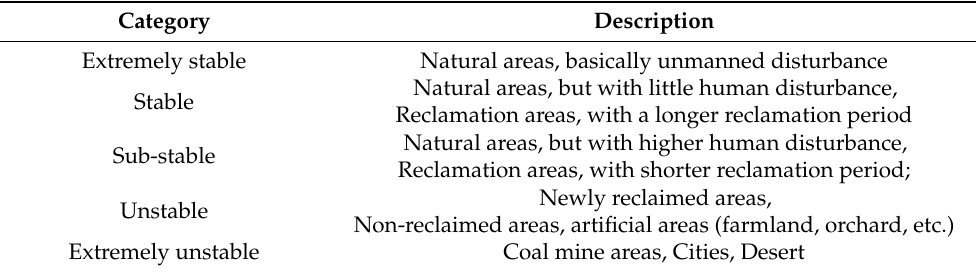
Table 2. Classification of ecological stability in the coal mining area. Category Description Extremely stable Natural areas, basically unmanned disturbance Natural areas, but with little human disturbance, Stable Reclamation areas, with a longer reclamation period Natural areas, but with higher human disturbance, Sub-stable Reclamation areas, with shorter reclamation period; Newly reclaimed areas, Unstable Non-reclaimed areas, artificial areas (farmland, orchard, etc.) Extremely unstable Coal mine areas, Cities,